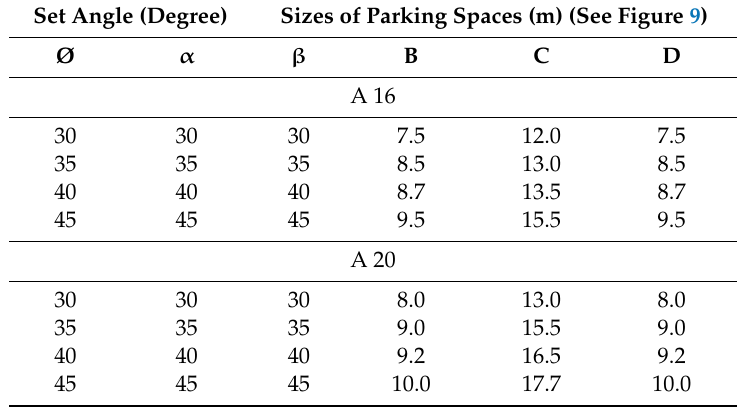
Table 5. Sizes of parking spaces at di ff erent corners of the parking of trucks (see Figure 15). Set Angle (Degree) Sizes of Parking Spaces (m) (See Figure 9) Ø α β B